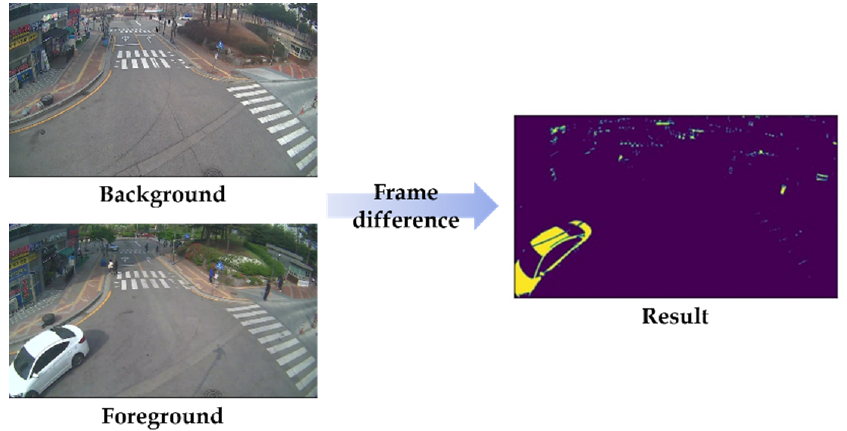
Figure 3. Example of frame difference.